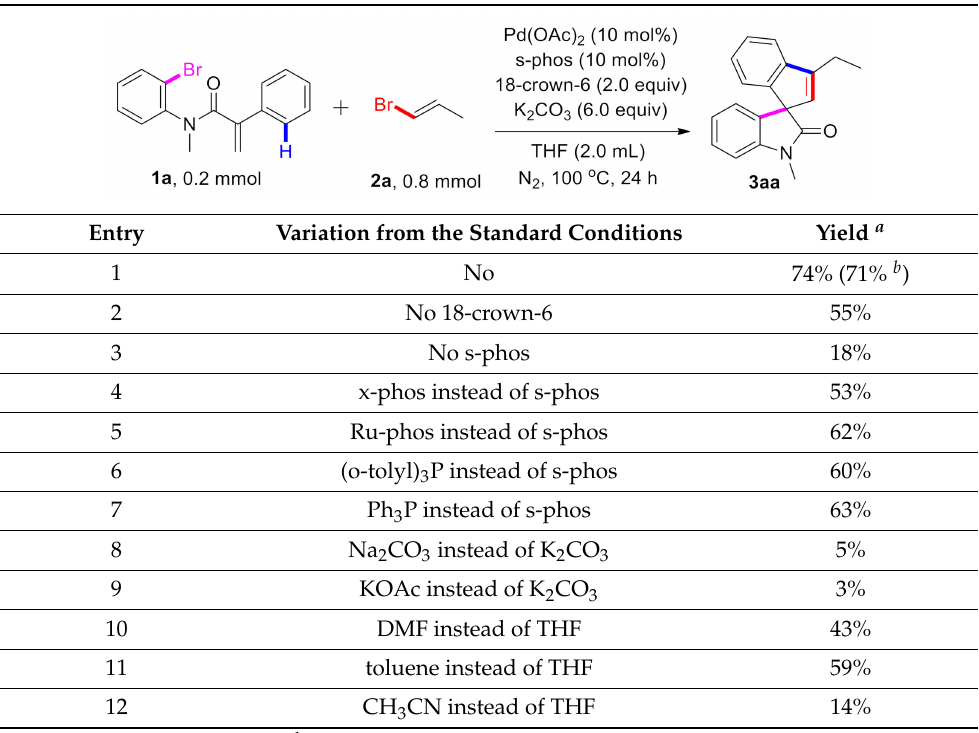
Table 1. Optimization of the reaction